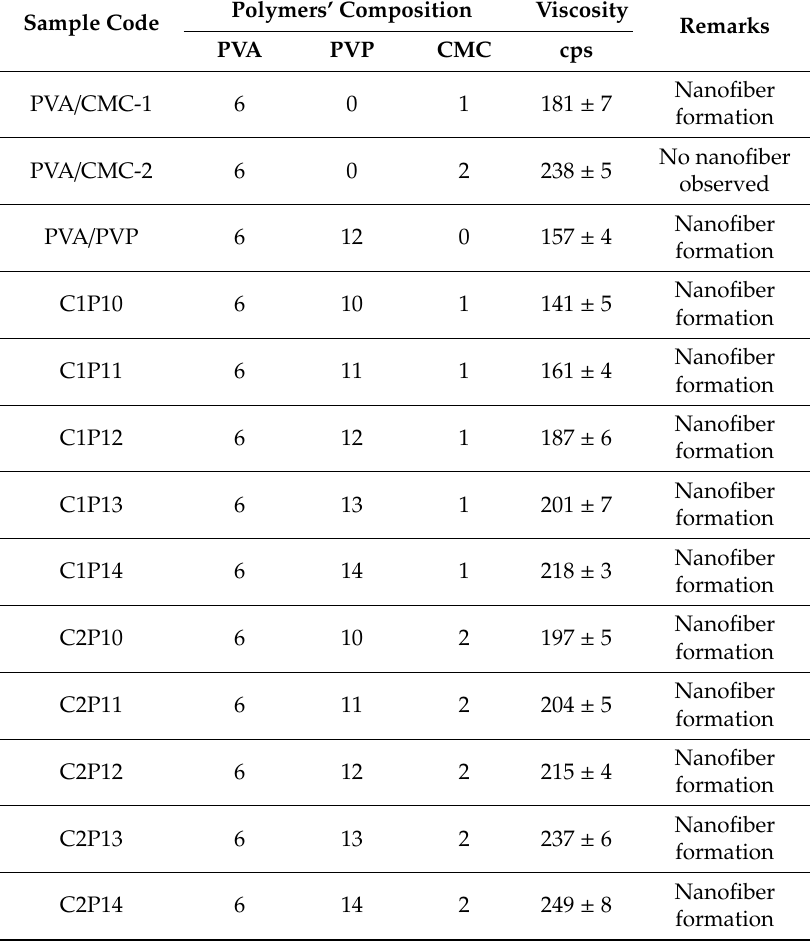
Table 1. Ratio of polymers ( w / w ) in tri-component composite nanofibrous mats and viscosities of spinning solutions with standard